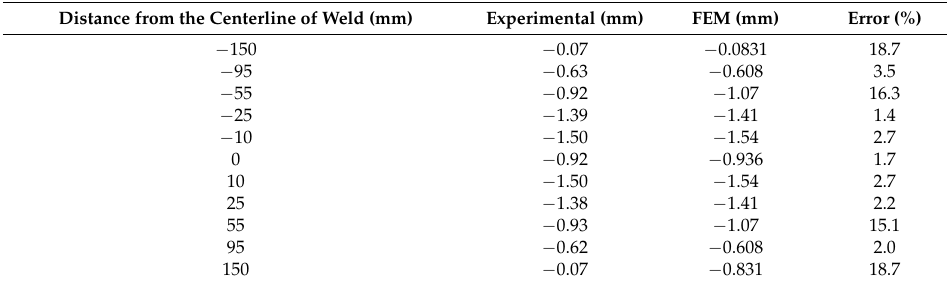
Figure 13. Comparison of the angular distortion in Z direction between simulation and experiment. Table 7. Values of the angular distortion obtained from simulation and experiment.